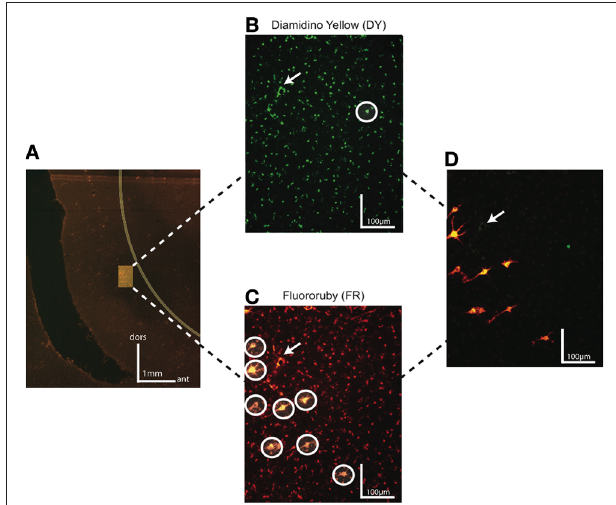
FIGURE 3 | Dark fi eld photomicrographs of FEF neurons labeled by injections in SC and area V4 in monkey R. (A) Low magnifi cation of FEF region with highlighted infragranular layers containing Diamidino yellow (DY) and Fluororuby (FR) labeled neurons projecting to V4 and SC, respectively. The border between gray and white matter is represented by a yellow line. The scale bar shows the orientation of dorsal (dor) and anterior (ant) for this section. (B) High magnifi cation photomicrograph of FEF neurons labeled with DY injected in V4. (C) High magnifi cation photomicrograph of FEF neurons from the same region as (B) labeled with FR injected in SC. In both (B) and (C) labeled neurons are circled in white to distinguish from surrounding artifacts. (D) DY and FR labeled neurons on a superimposed photomicrograph of (B) and (C) . In (B–D) , the white arrow marks an artifact present on each section and noticed under both DY and FR fi lters. No double-labeled neurons were